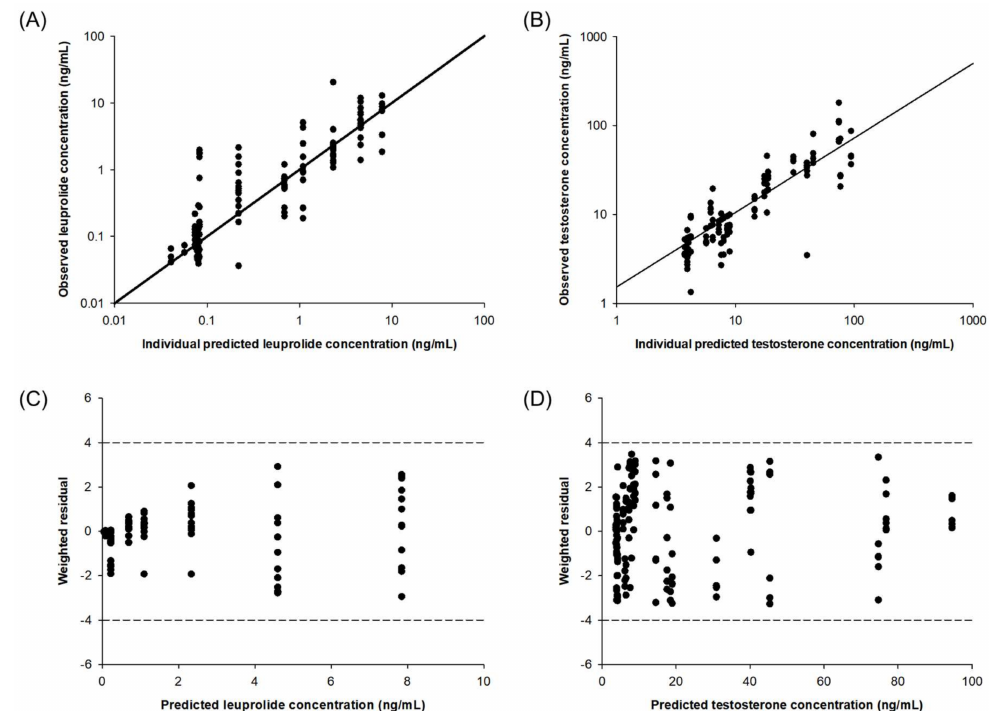
Figure 3. Diagnostic plots of the PK–PD model for leuprolide and testosterone: correlation of individual observed versus predicted concentration for leuprolide ( A ) and testosterone ( B ). Plots of weighted residual versus predicted concentration of leuprolide ( C ) and testosterone ( D